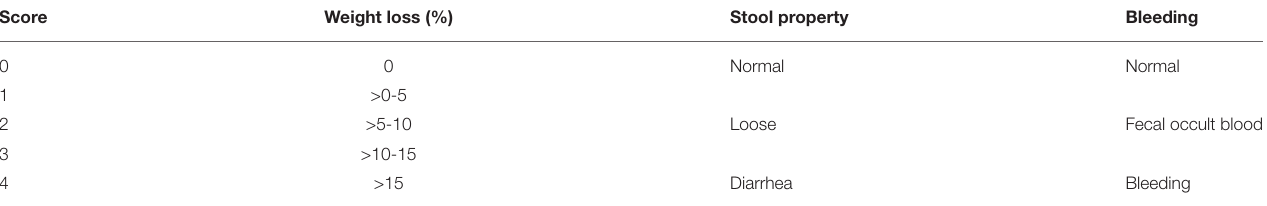
TABLE 2 | Histological injury score chart. Grade 0 Inflammation None Mild Mucosal damage Crypt